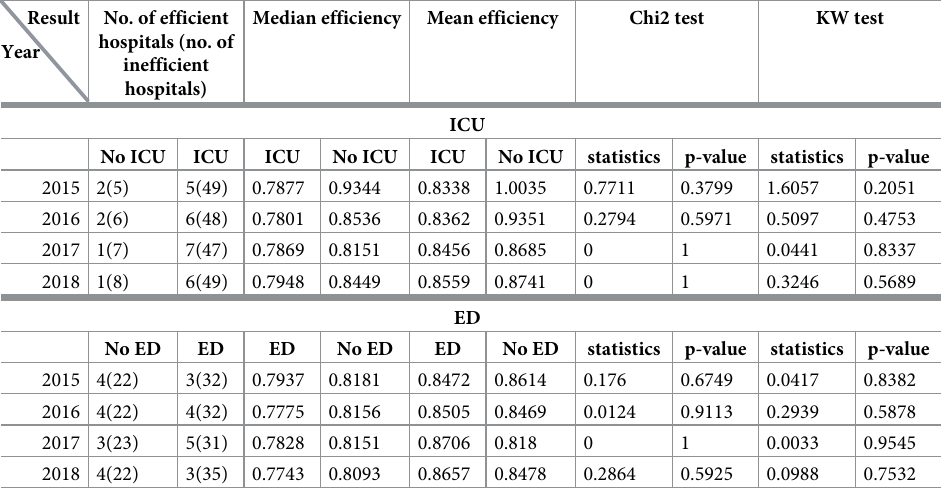
Table 10. Efficiency of public hospitals with respect to an ED and ICU ( traditional